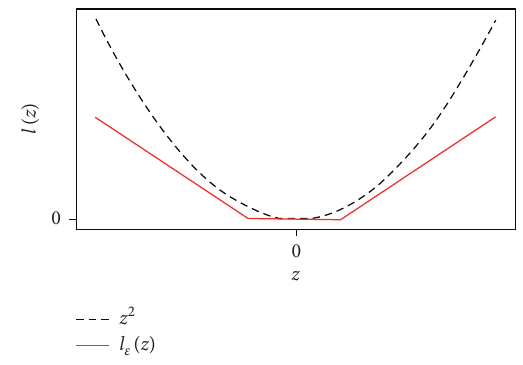
Figure 11: ( ε ) -insensitive loss function.